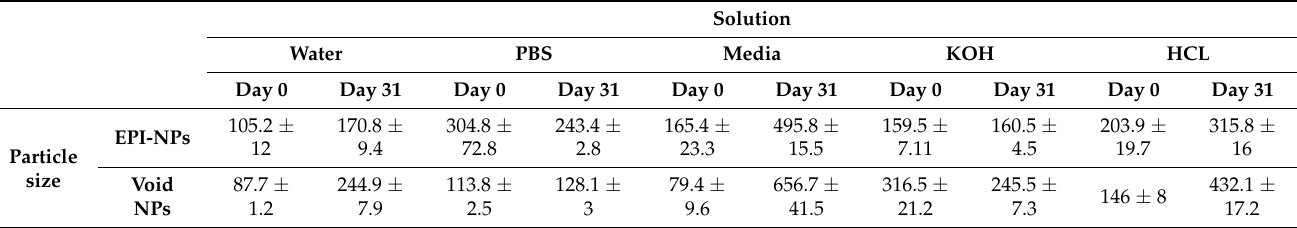
Table 3. Mean particle size at day 0 and day 31 for EPI-NPs and void NPs. The data represent the mean average of the five instrument runs for each sample ± SD.